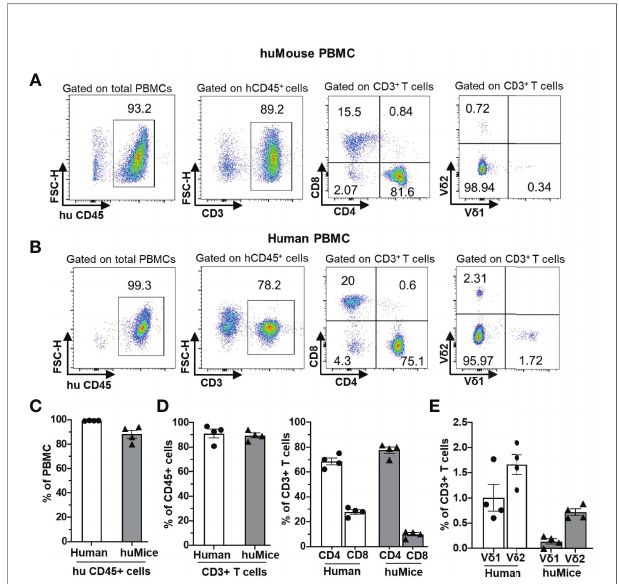
FIGURE 1 | Human ab and gd T cell development in the peripheral blood of BLT huMice. (A, B) Representative fl ow cytometry analysis of human immune cell (hCD45 + ) reconstitution along with lymphocytes subsets, including ab T cells (CD3 + ), (CD4 + ), (CD8 + ), and gd T cells (V d 1 and V d 2 T cell subsets) in PBMC of BLT huMice (A) at ten weeks after transplantation and uninfected human (B) . (C – E) Quanti fi cation of human CD45 + lymphocytes (C) , human ab (D) , and gd (E) T cell subsets in PBMCs of BLT huMice and healthy humans (n = 4 biological replicates